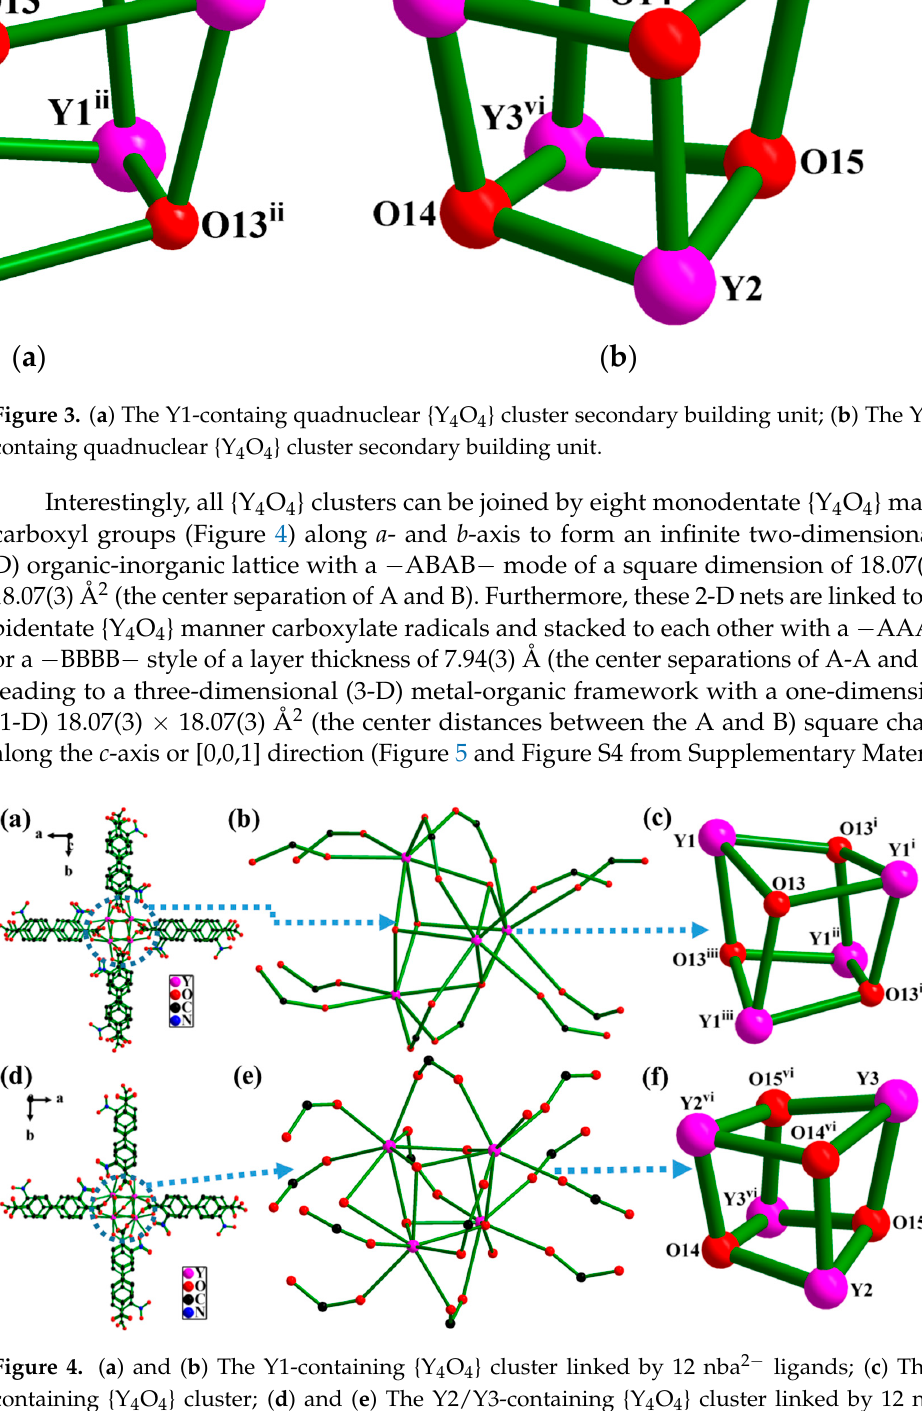
Figure 4. ( a ) and ( b ) The Y1-containing {Y 4 O 4 } cluster linked by 12 nba 2 − ligands; ( c ) The Y1- containing {Y 4 O 4 } cluster; ( d ) and ( e ) The Y2/Y3-containing {Y 4 O 4 } cluster linked by 12 nba 2 − ligands; ( f ) The Y2/Y3-containing {Y 4 O 4 } cluster.